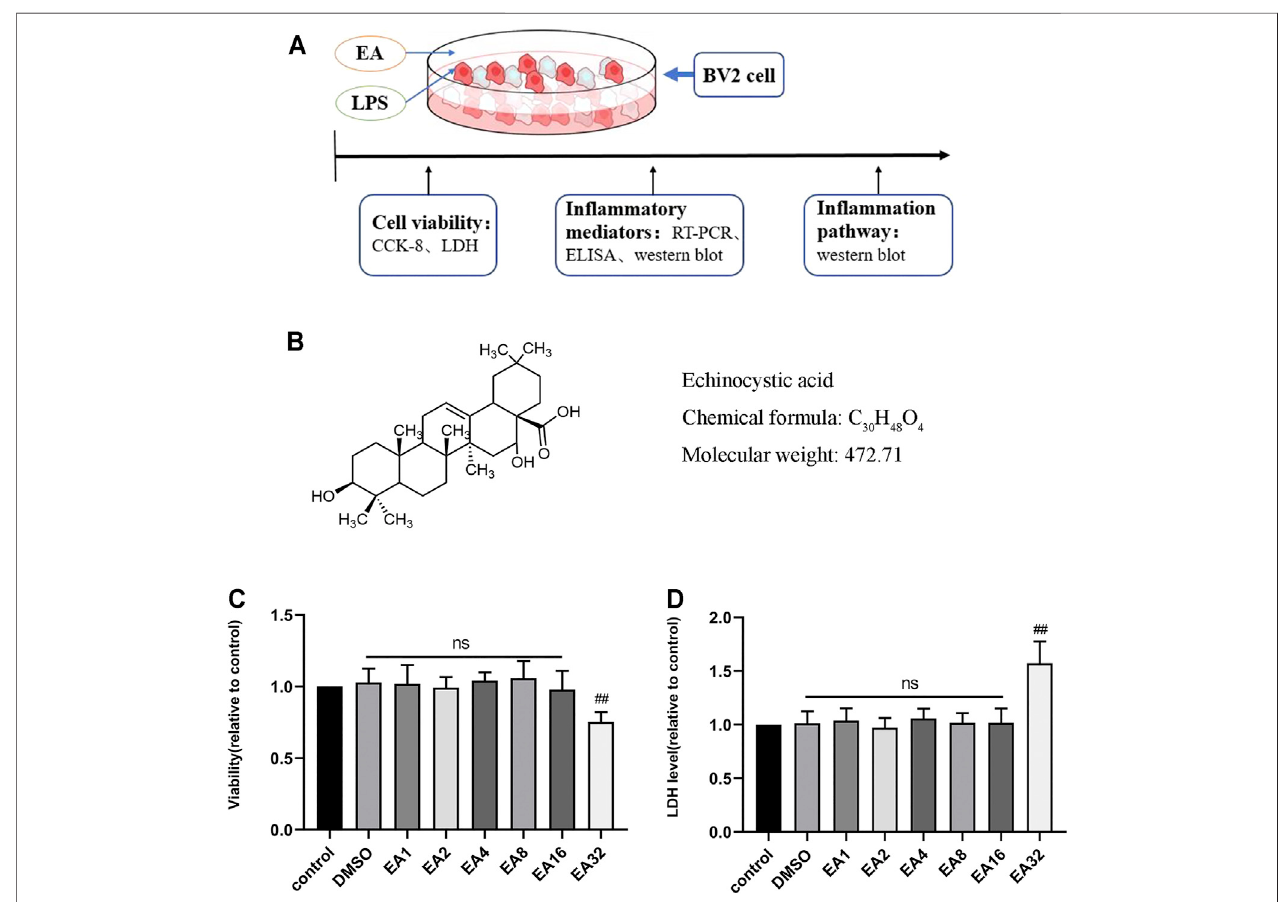
FIGURE 1 | Effect of EA on the viability of BV2 cells. (A) Processing of BV2 cells. (B) The structure of EA. (C) The survival rate of BV2 cells treated with different concentrations of EA (1, 2, 4, 8, 16, and 32 μ M) for 24 h via CCK-8 experiment. (D) Effects of EA on LDH release in BV2 cells. Results are represented as means ± SD ( n (cid:1) 4). ## p < 0.01 vs. control